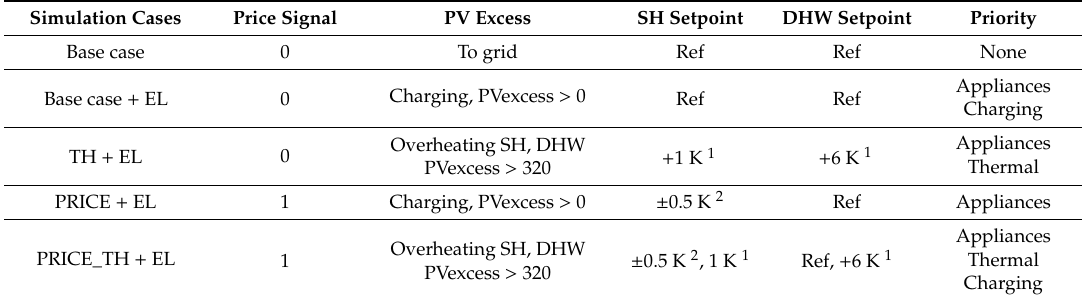
Table 3. Control strategies overview for on–o ff control of the HP and the electrical storage. Base case is the normal control of the heat pump without smart algorithms, and all examined cases include